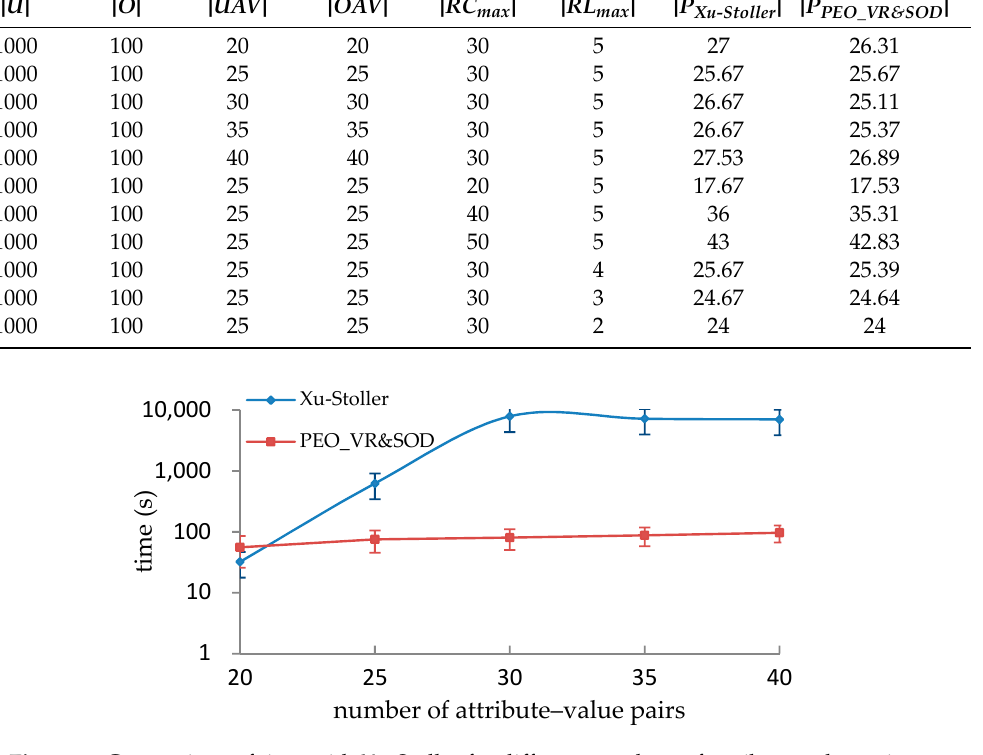
Figure 5. Comparison of time with Xu-Stoller for different numbers of attribute-value pairs.